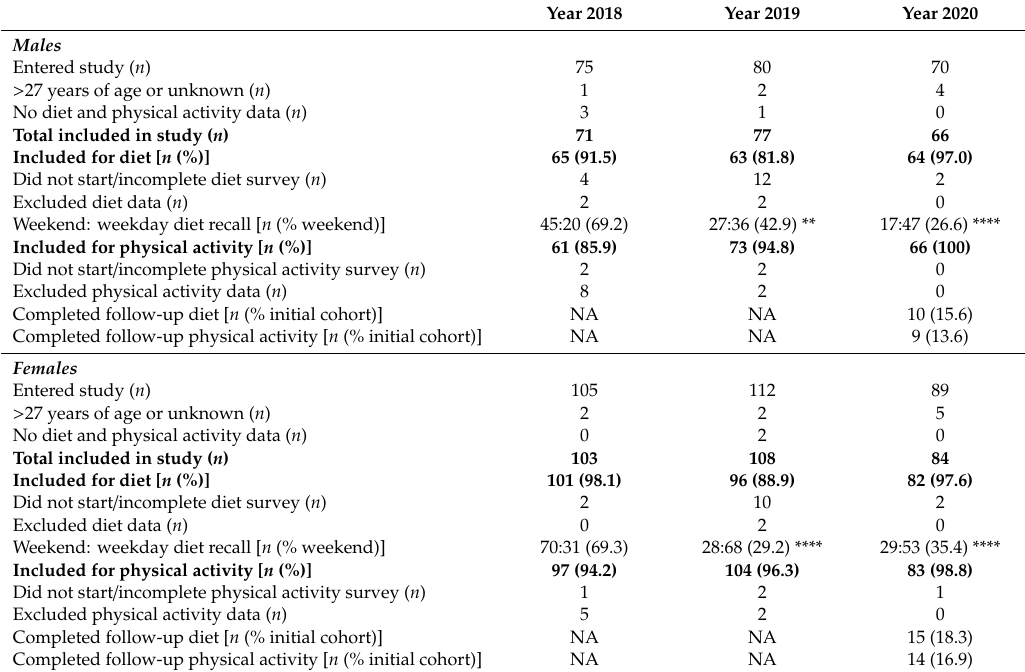
Table 1. Participants included in the